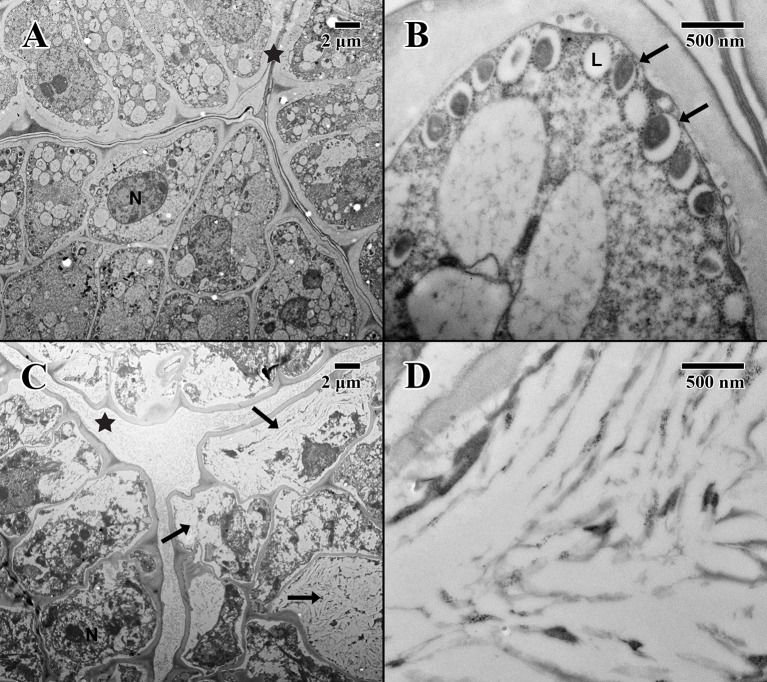
Transmission electron microscope micrographs of the epicotyl region of date palm embryos in dry state. (A) ×1,000 2004 embryo (MSB accession no. 211945). Scale bar = 2 μm. (B) ×10,000 2004 embryo (MSB accession no. 211945). Scale bar = 500 nm. (C) ×1,000 1873 embryo (EBC accession no. 36007). Scale bar = 2 μm. (D) ×10,000 1873 embryo (EBC accession no. 36007). Scale bar = 500 nm. (N, nucleus; L, lipid body; Star = embryonic pore, arrows = explained in text.